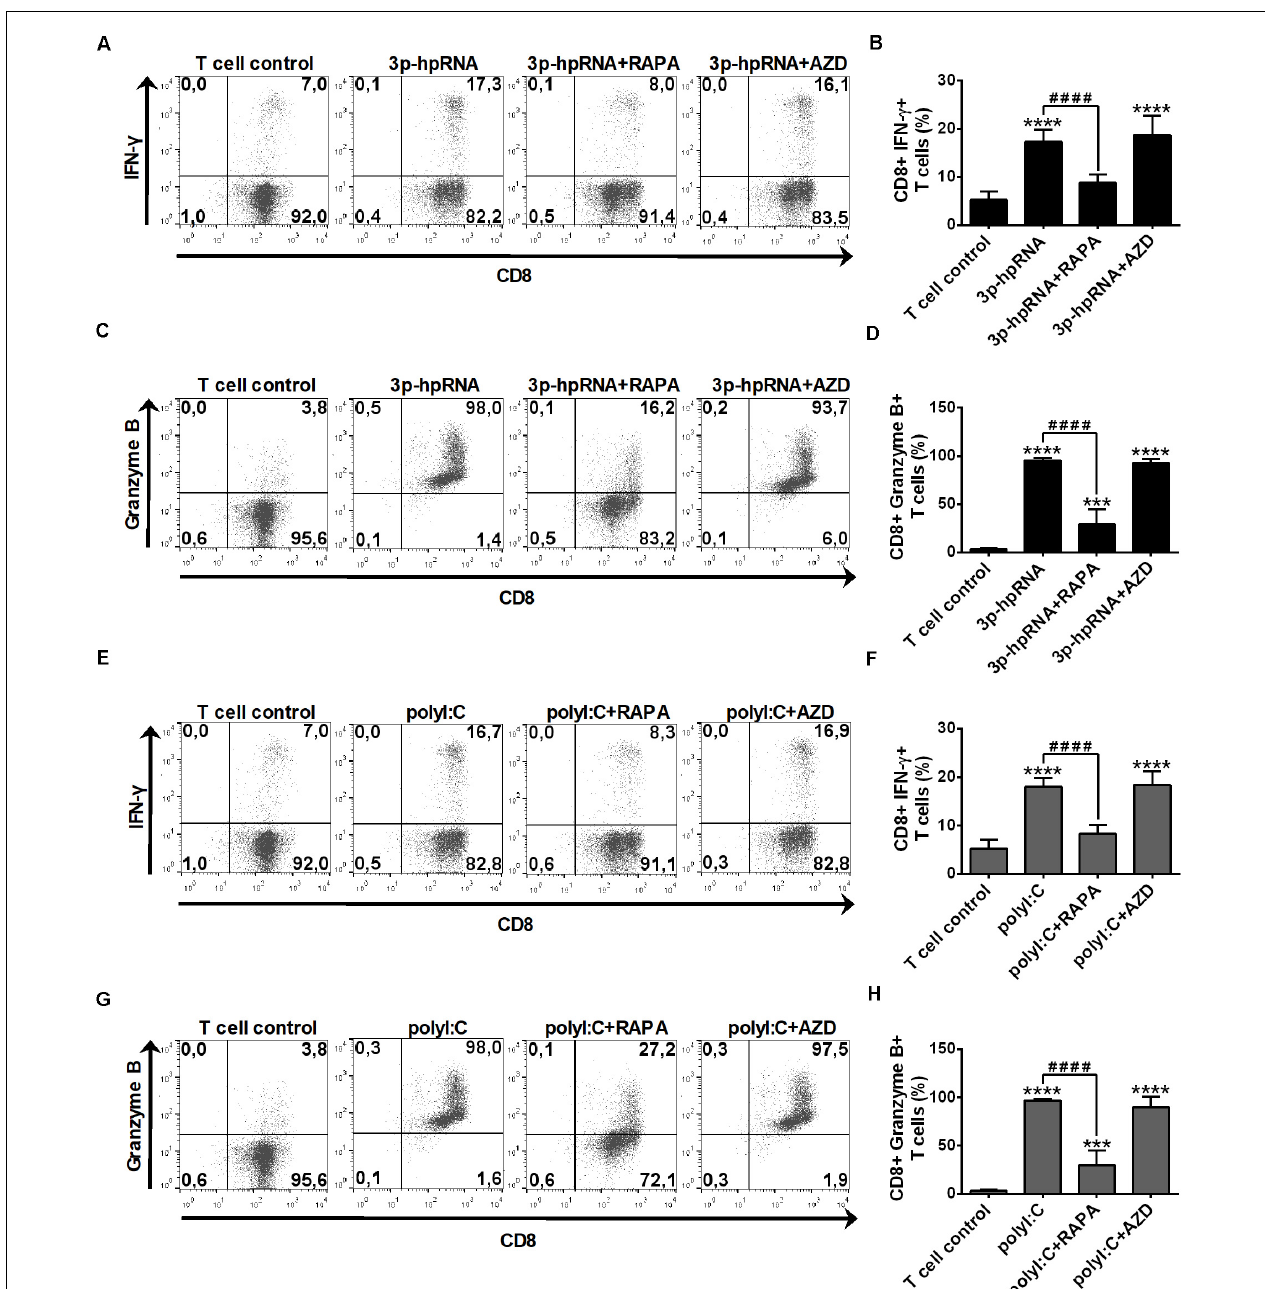
FIGURE 11 | The T cell activating capacity of RLR-stimulated primary human pDCs is decreased by rapamycin but not AZD8055 pre-treatment. Naïve CD8 + T cells were co-cultured with allogeneic primary human pDCs pre-treated with the indicated reagents. After 6 days of co-cultivation T cells were stimulated with phorbol myristate acetate (0.1 µ g/ml) and ionomycin (1 µ g/ml) in the presence of monensin for 5 h. IFN-y and Granzyme B production of CD8 + T cells was measured by intracellular cytokine staining and flow cytometry. (A,C,E,G) Data from one representative experiment are shown. Numbers in each quadrant represent the percentage of cells. In A and E as well as in C and G T cell controls are the same, since representative dot plots originate from the same set of experiment from one single donor. (B,D,F,H) Bar graphs represent the mean ± SD of 6 independent experiments. *** p < 0.01, **** p < 0.0001 vs. control; #### p < 0.0001. AZD: AZD8055, RAPA: